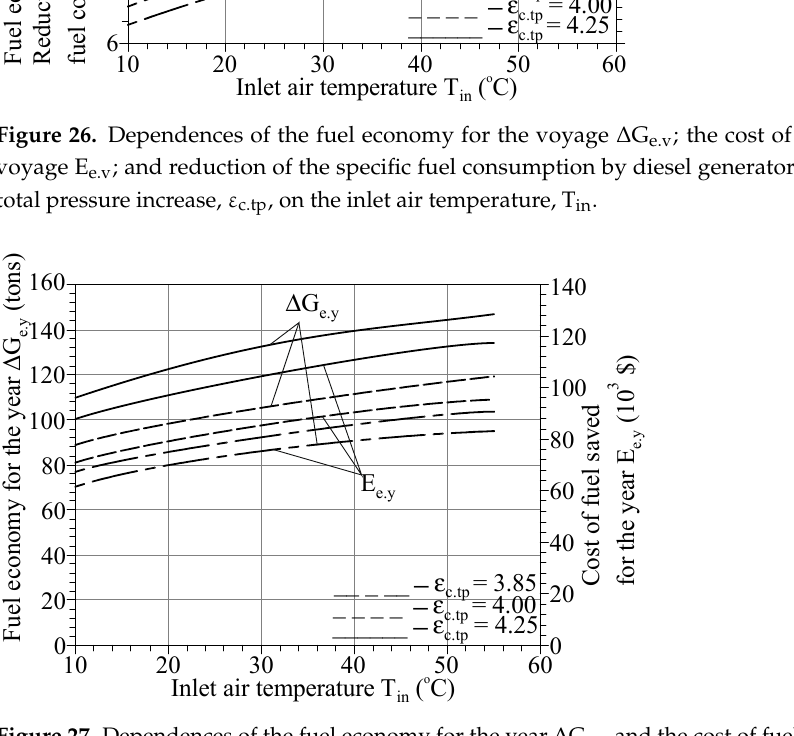
Figure 27. Dependences of the fuel economy for the year Δ G e . y and the cost of fuel saved for the year E e . y at different total pressure increase, ε c . tp , on the inlet air temperature, T in .